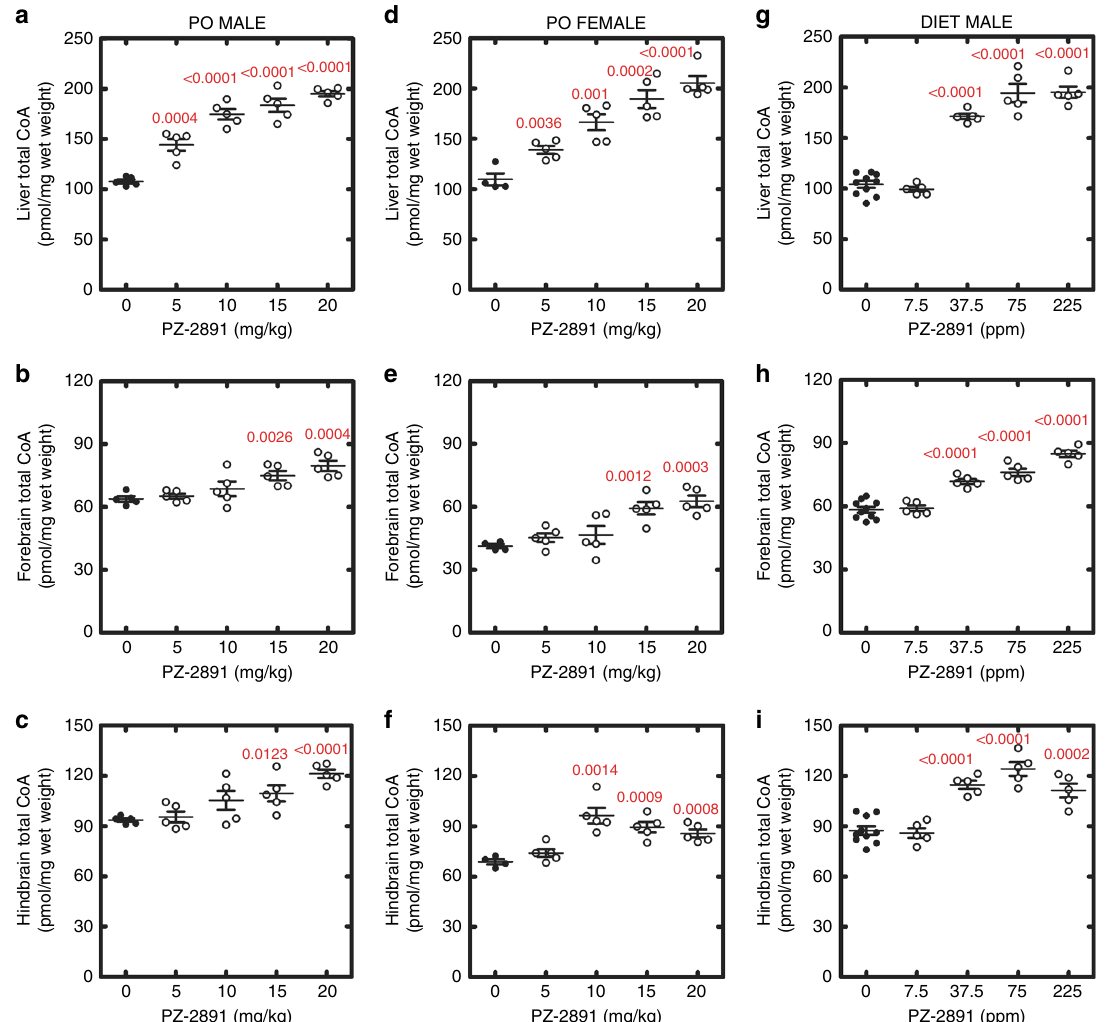
Fig. 6 Activation of CoA synthesis in liver, forebrain and hindbrain of male and female animals treated with PZ-2891. Groups of 5 mice were administered the indicated amounts of PZ-2891 plus 100 mg/kg pantothenate by oral gavage every 12 h for 5 doses. Four hours after the last dose, the tissues were harvested and the tissue CoA levels determined. Control CoA levels (closed circles); PZ-2891 treated CoA levels (open circles). a Male liver. b Male forebrain. c Male hindbrain. d Female liver. e Female forebrain. f Female hindbrain. Groups of 5 mice were maintained on chow forti fi ed with 1000 ppm pantothenate and the indicated levels of PZ-2891. The mice were maintained on the diets for 4 weeks and their tissues were harvested and the CoA levels determined. g Liver CoA levels. h Forebrain CoA levels. i Hindbrain CoA levels. Statistical signi fi cance was determined using Student ’ s t-test calculated with Graph-Pad software and the p values (red) are noted on the fi gure panels in red. Means ± SEM are